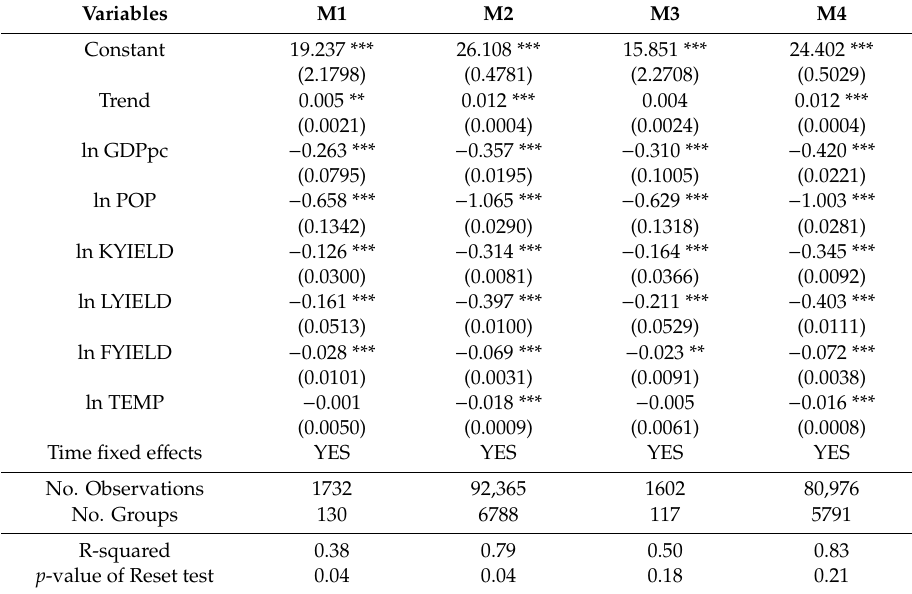
Table 2. Estimation